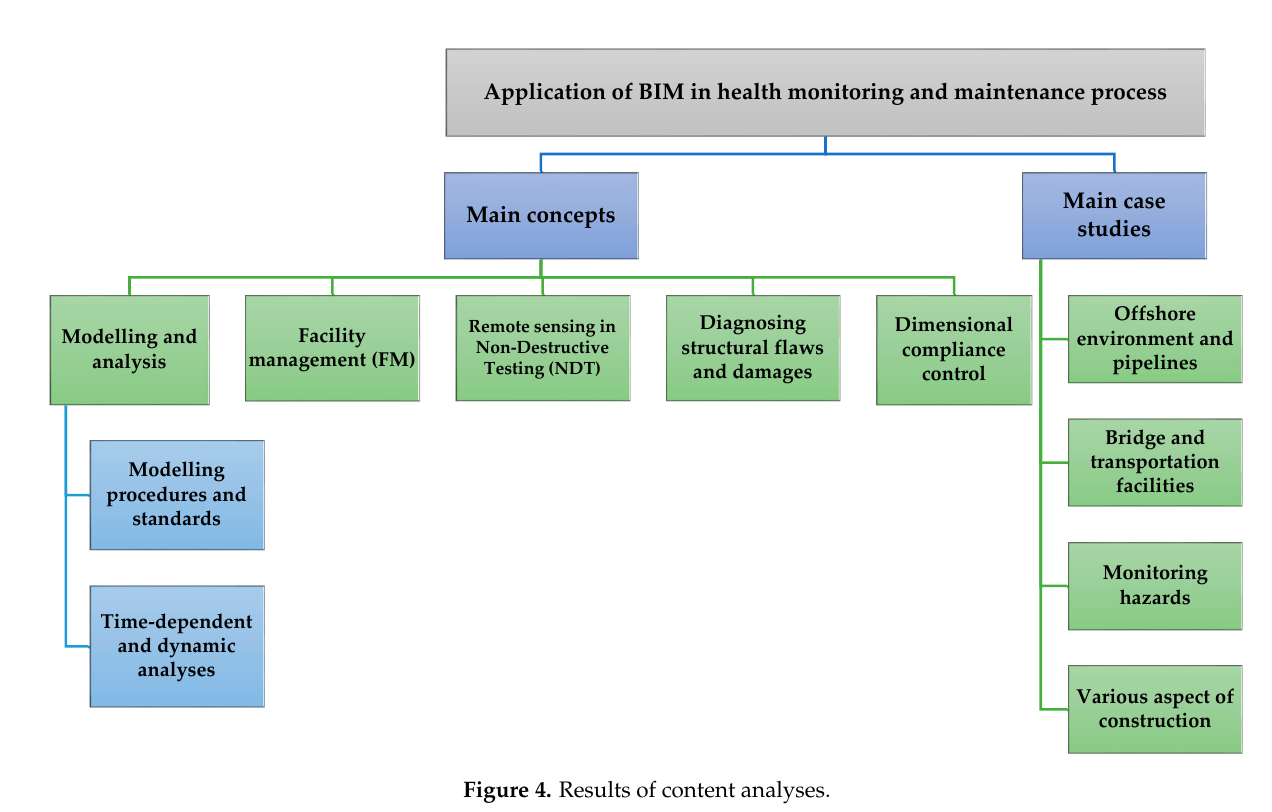
Figure 4. Results of content analyses.